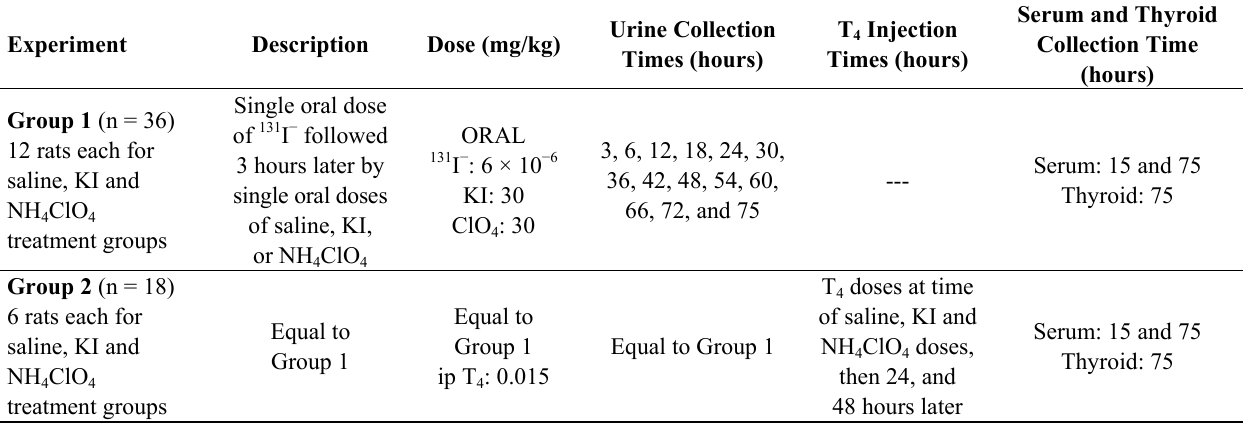
Table 1. Summary of experiments in the rat to characterize excretion profiles of 131 I − following prophylactic administration of saline, KI, or perchlorate with and without hormone T 4